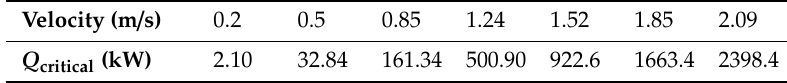
Table 1. The critical HRR for different wind velocities.